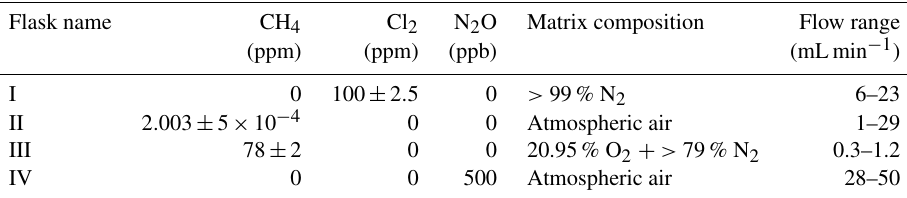
Figure B1. (a) General setup for setups 2–4 (Table D4). (b) General setup for N 2 O experiments. Gas flasks are presented in Table B1. ACT: activated carbon trap. MFC: mass flow controller. Table B1. Table summarizing the gas flask used in the